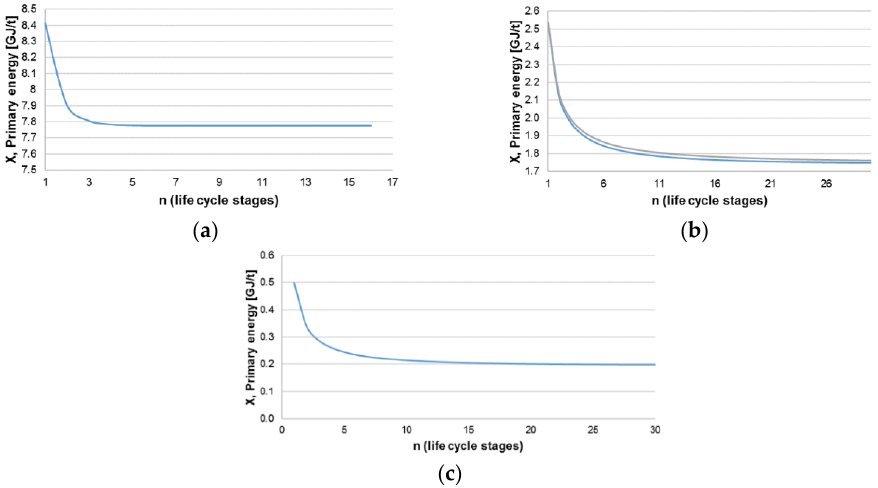
Figure 14. ( a ) Energy embodied in metal collected from the production stage and re-melted in-house in the cast-iron foundries (assumed 2% of the embodied energy for pig iron addition), ( b ) energy embodied in core sand after reclamation process, and ( c ) energy embodied in green sand for its multiple reuse.